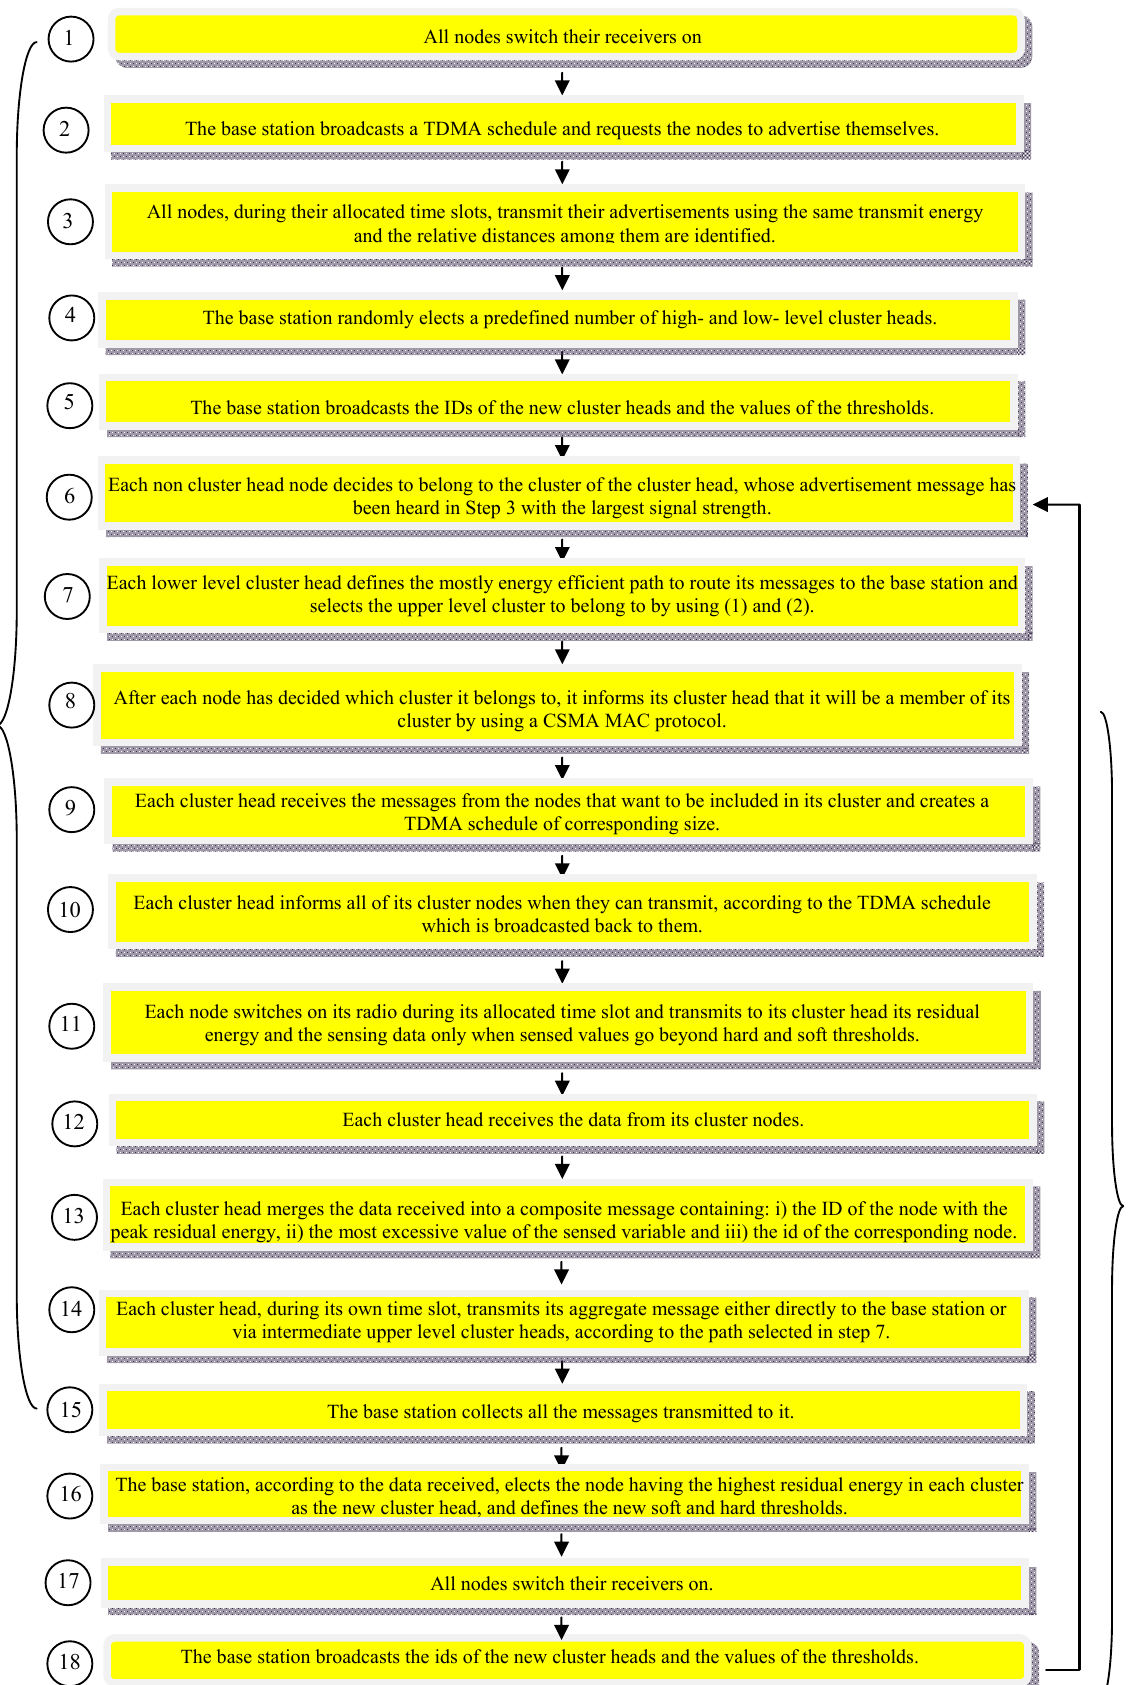
Figure 2. Synoptic overview of the algorithm chart of SHPER